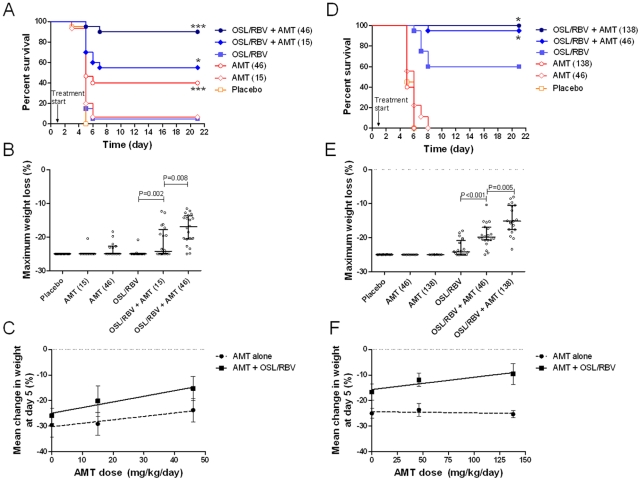
The activity of AMT is enhanced in combination with OSL and RBV against drug susceptible and resistant viruses.(A,B,C) Mice infected with AMT-susceptible A/H5N1 were treated with escalating doses of AMT (0, 15, and 46 mg/kg/day) either as a single agent or in the context of TCAD therapy (with 25 mg/kg/day OSL and 27 mg/kg/day RBV). (D,E,F) Mice infected with AMT-resistant 2009 A/H1N1 were treated with escalating doses of AMT (0, 46, and 138 mg/kg/day) either as a single agent or in the context of TCAD therapy. Kaplan-Meier survival curves for (A) A/H5N1 or (D) 2009 A/H1N1 infection. *P<0.05 versus no AMT, ***P<0.05 versus low dose AMT. Distribution of maximum body weight loss over the course of infection for (B) A/H5N1 influenza or (E) 2009 A/H1N1 influenza. Data bars represent median +/− interquartile range. The mean percentage weight change at day 5 in mice infected with lethal doses of (C) A/H5N1 influenza and (F) 2009 A/H1N1 influenza. Data bars represent mean +/− standard deviation.